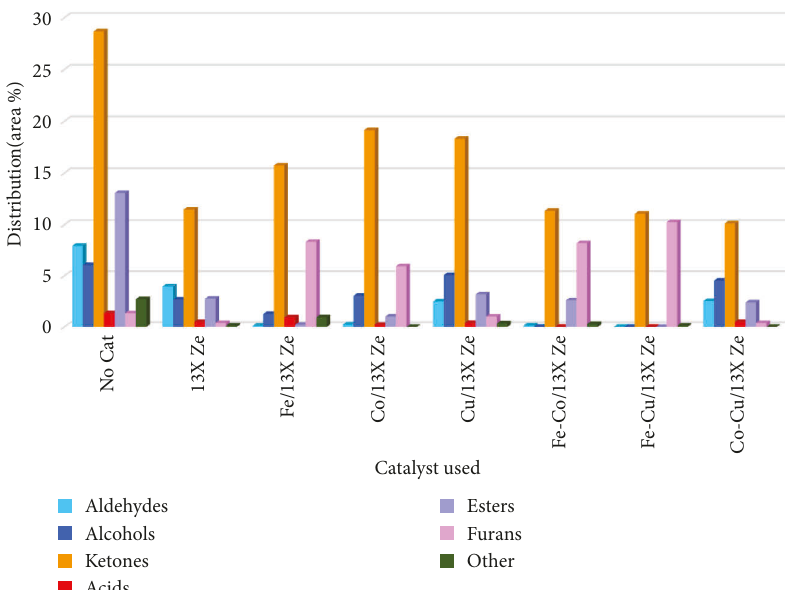
Figure 11: Effects of the metals/13X zeolite catalysts on the distribution of oxygenated compounds in the bio-oil composition obtained by RRB pyrolysis.